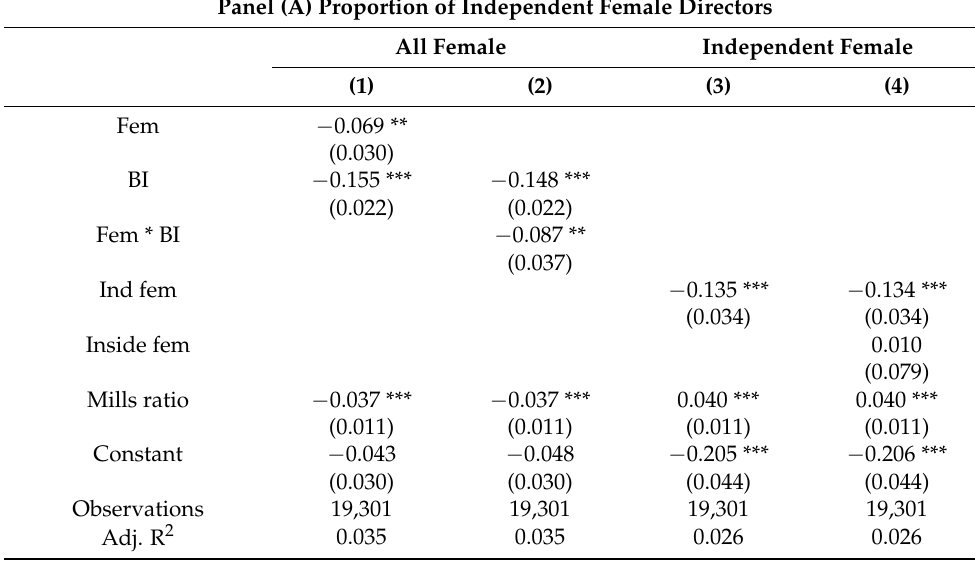
Table 10. Independent female directors and financial fraud. Heckman correction (second